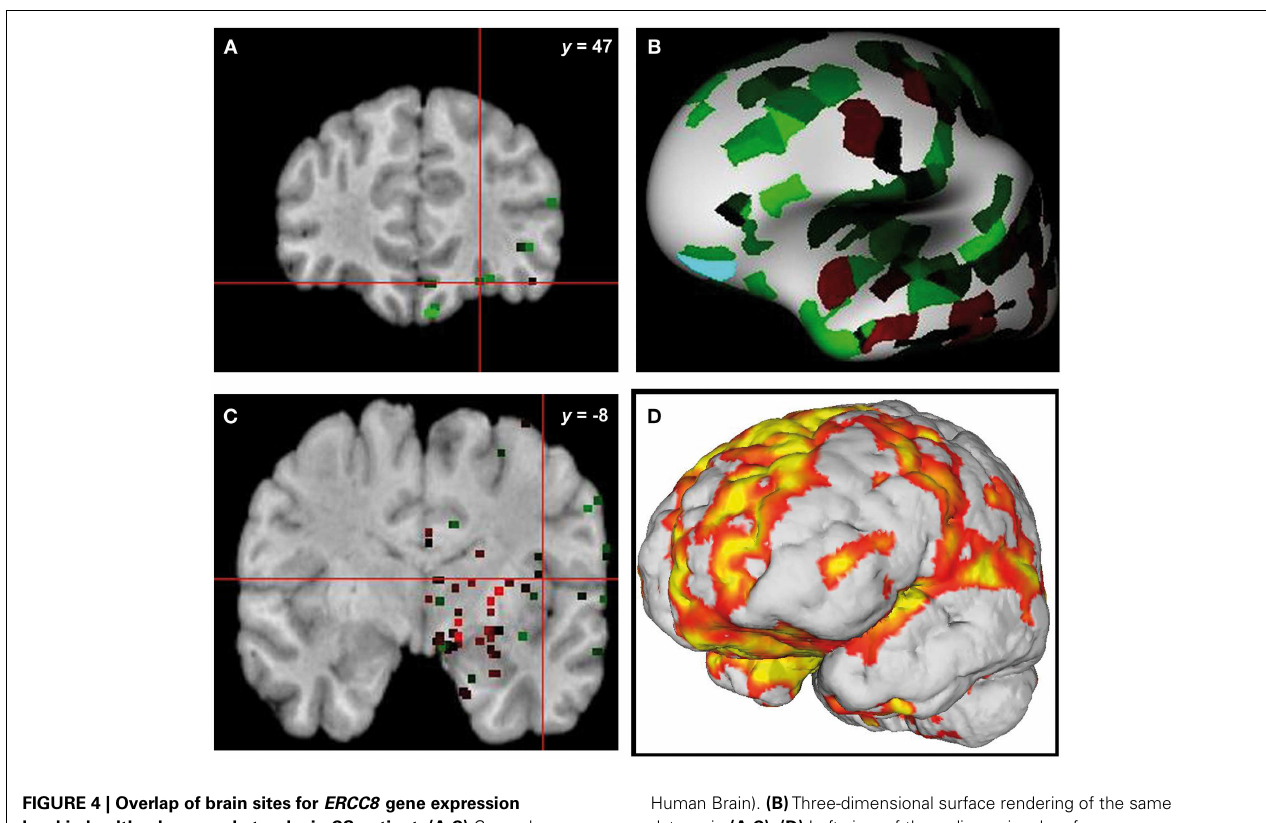
FIGURE 4 | Overlap of brain sites for ERCC8 gene expression level in healthy donor and atrophy in CS patient . (A,C) Coronal sections depicting two sites of gene expression/atrophy overlap: orbitofrontal cortex and insular cortex in donor H0351.1016 (Allen